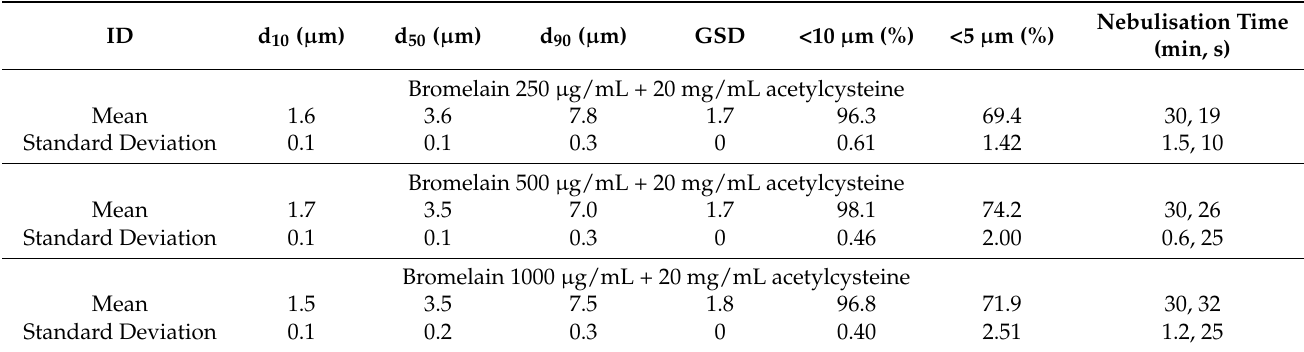
Table 1. Volumetric droplet diameter distributions of BromAc aerosols emitted from the jet nebulizer InnoSpire.